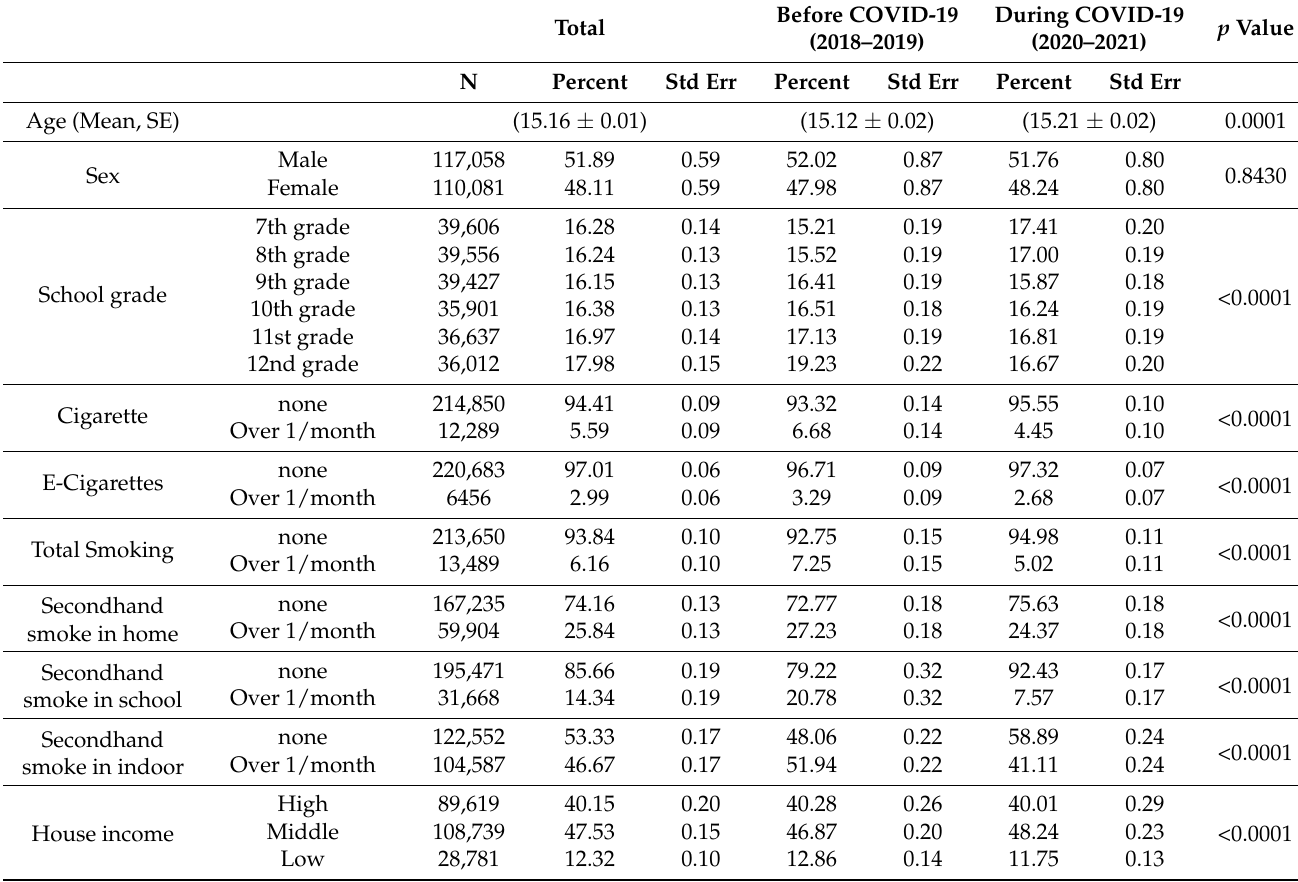
Table 1. General Information of Study